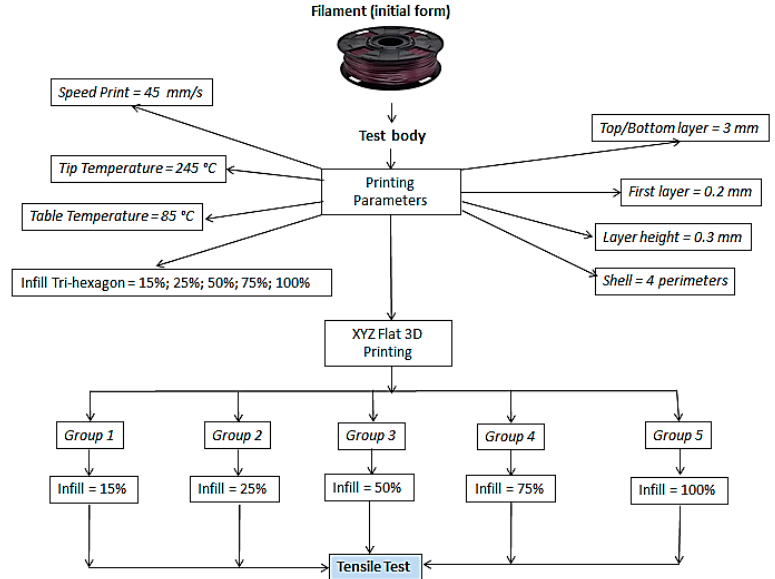
Figure 5. Experimental methodology flowchart.